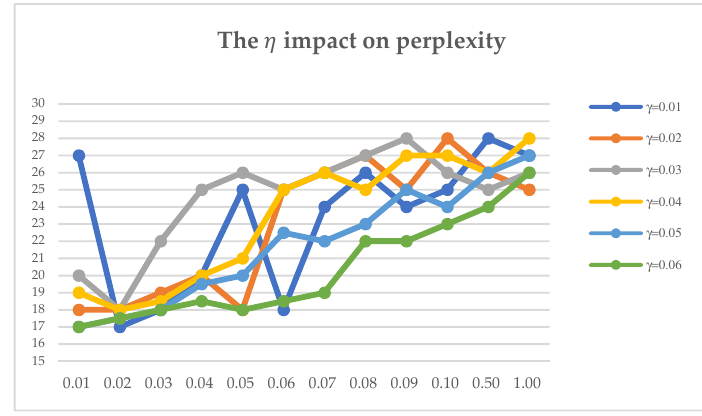
( b ) Figure 6. ( a ) Comparison experiment on Flickr; ( b ) comparison experiment on Twitter. 5.5.3. Experiments with Different Parameter Settings The performance of multimodal sentiment analysis in our model also depends on the selection of parameter γ and parameter η . Previous studies [54] have shown that LDA can generate good results by using symmetric prior knowledge settings. However, for document topic distribution types, the experimental results obtained by asymmetric prior knowledge are better than the former. In order to prove that parameters γ and η will affect the performance of the proposed model, we set up a comparison experiment on different parameter values in the experiment. Finally, in our proposed model, parameters are set based on the study of Griffith et al. [63], that is, γ = (0.06 × C) ÷ T, where C is the average of document length and T represents the sum of sentimental labels, parameter η = 0.02. The assignment of the super parameter α can be obtained and iterated directly by using the maximum likelihood estimation method [64]. A common indicator is adopted here to measure the parameter performance: perplexity. Perplexity is usually used to measure the probability distribution or the quality of a probability model’s prediction sample, that is, to estimate the quality of a probability model. It is calculated by the following formula: 𝑃(𝑝) = 2 (cid:3009)((cid:3043)) = 2 (cid:2879)∑ (cid:3043)((cid:3051))(cid:2922)(cid:2925)(cid:2917) (cid:3118) (cid:3043)((cid:3051)) (cid:3299) .